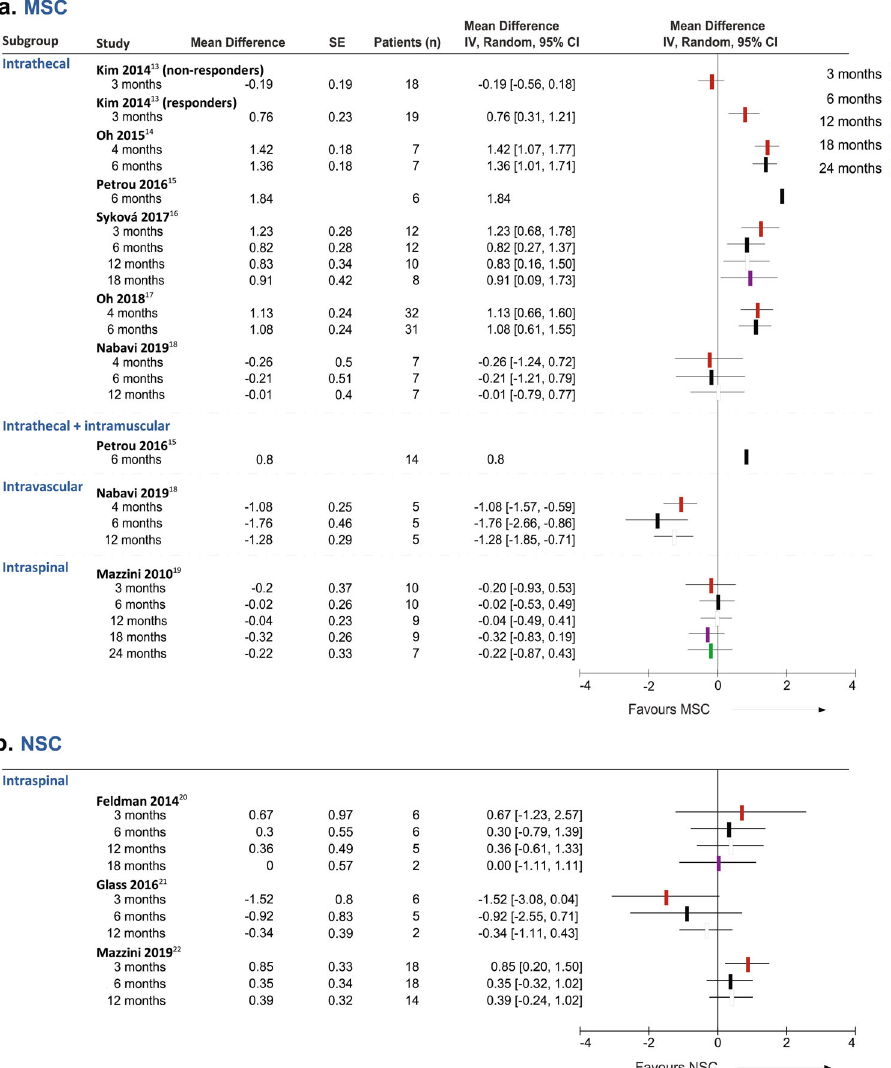
Fig. 2 Effect of SC therapy on clinical score. Forest-plots of the changes in ALSFRS-R, in points per month, between the lead-in period and the follow-up [(score at t x post − score at t 0 )/ x ] minus [(score at t 0 − score at t X pre)/ x ], evaluated at different follow-up time points, in patients infused with a MSCs or b NSCs. Squares and black lines represent the mean differences and 95% CI of individual studies and the different colors stand for the follow-up times, as indicated in the